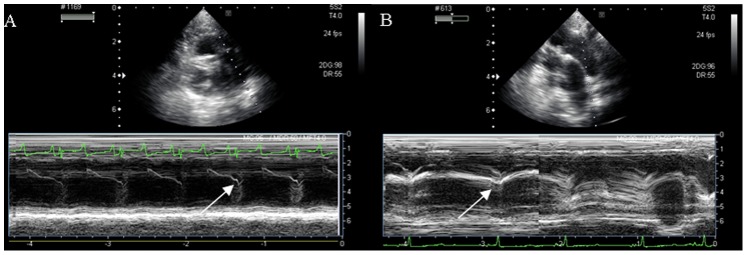
M-mode imaging in all minipigs at 6 weeks after MCT or placebo injection.Panel A: a-wave in the control group. Panel B: The V-shaped signals with no a-wave in the MCT group (arrows).